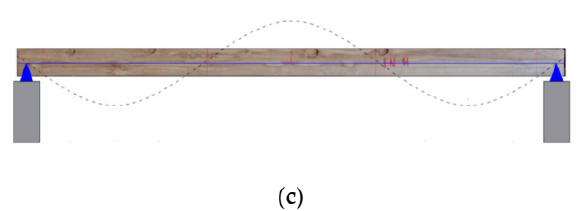
Figure 6. Theoretical first three resonant vertical vibration modes: ( a ) First mode, ( b ) second mode, and ( c ) third